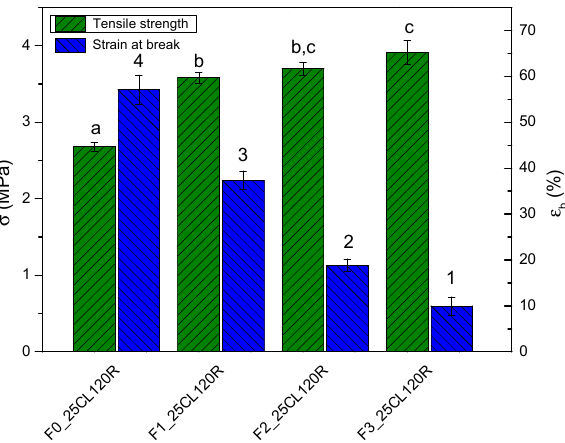
Figure 6. Results of tensile strength and strain at break for TPWF/PCL blends based on F0, F1 and F3 flours, containing 25% wt. of PCL and processed at 120 rpm. (a–c, stress values) (1–4, strain values) Different superscripts within the same column group (stress or strain values) indicate significant differences among formulations ( p < 0.05).